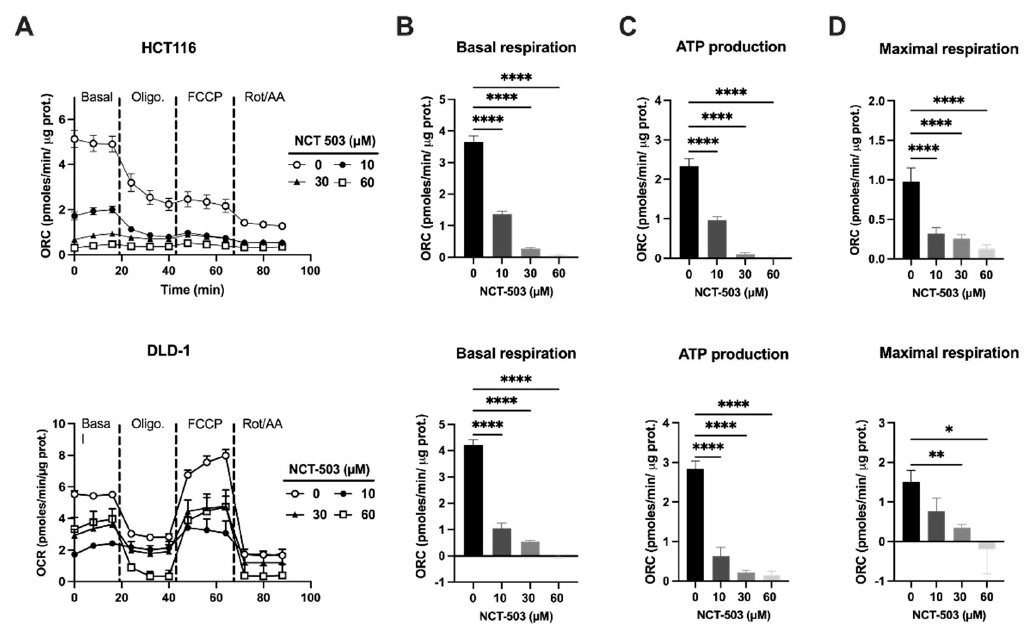
Figure 2. PHGDH inhibition affects mitochondrial cellular respiration under normoxic conditions. ( A ) Representative experiment showing the oxygen consumption rates (OCR) of normoxic HCT116 (top) and DLD-1 (bottom) was measured upon treatment with NCT-503 (16 h) at indicated concen-